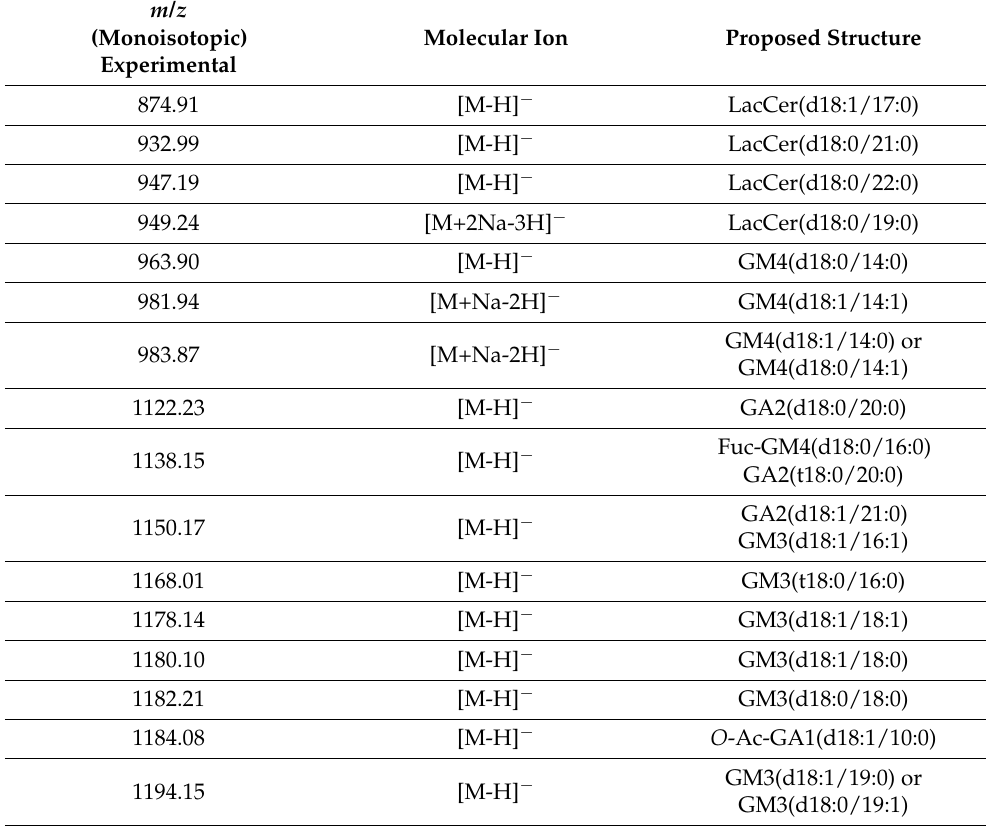
Figure 10. ( ‐ ) Chip ‐ nanoESI QTOF MS of the native GG mixture isolated from brain metastasis of Figure 10. (-) Chip-nanoESI QTOF MS of the native GG mixture isolated from brain metastasis of LADC. Solvent: MeOH; sample concentration 2.5 pmol/ μ L; acquisition time 1 min; Chip ESI: 1.5 kV; LADC. Solvent: MeOH; sample concentration 2.5 pmol/ µ L; acquisition time 1 min; Chip ESI: 1.5 kV; Cone voltage: 45 V. Zoomed area: ( a ) m / z (800 ‐ 1350); ( b ) m / z (1400 ‐ 2100) (adapted with permission Cone voltage: 45 V. Zoomed area: ( a ) m / z (800–1350); ( b ) m / z (1400–2100) (adapted with permission from [160]). from [160]). Table 4. GGs and asialo ‐ GG species from brain metastasis of LADC detected by ( ‐ ) chip ‐ nanoESI Table 4. GGs and asialo-GG species from brain metastasis of LADC detected by (-) chip-nanoESI QTOF MS analysis of the native GG extract (adapted with permission from [160]). QTOF MS analysis of the native GG extract (adapted with permission from m/z